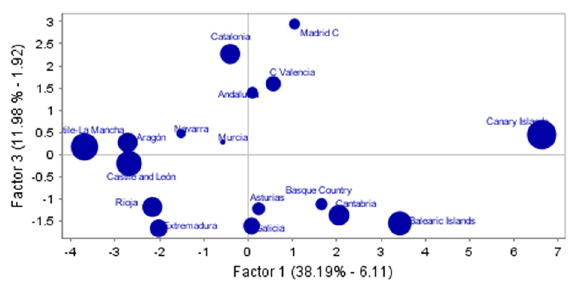
Fig. 3. Projection of the autonomous communities onto the second factorial plane. Source: own